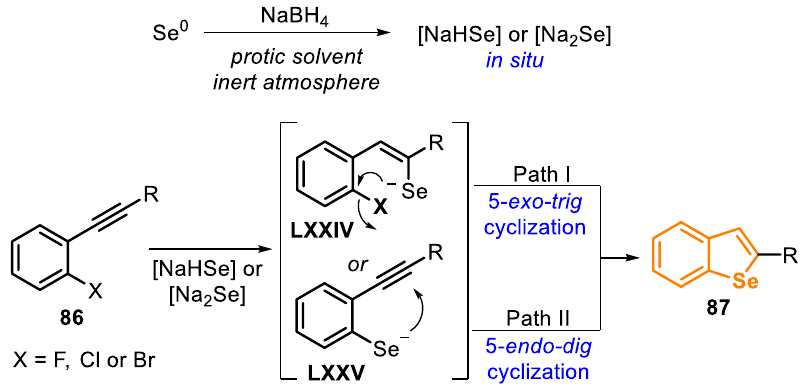
Scheme 60. General protocol for cyclization of type D precursors using NaBH 4 .